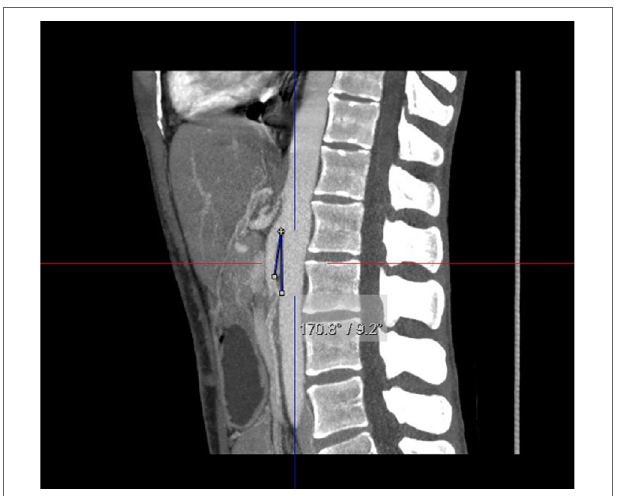
FIGURE 2 | Computerized Tomography of aortomesenteric angle (9.2°)